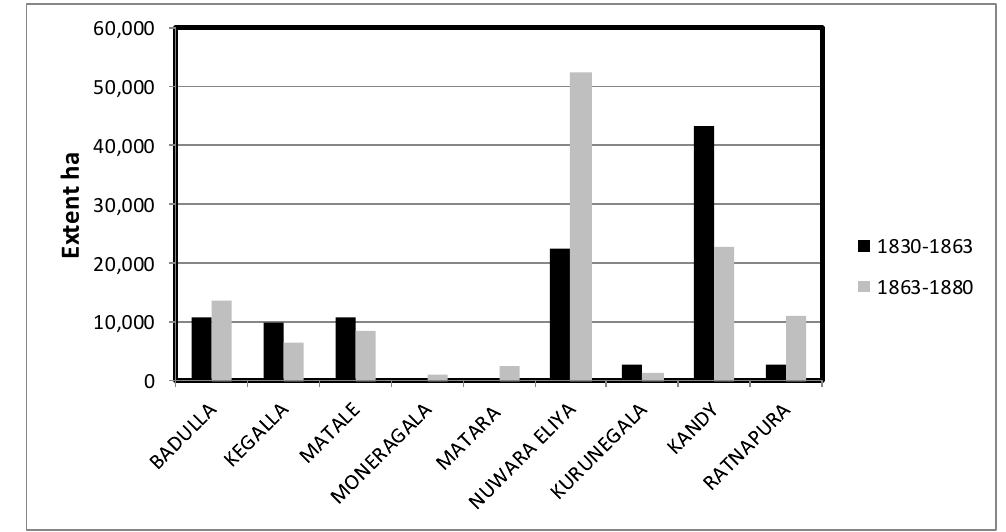
Figure 8: Distribution of coffee estates in the highlands by districts from 1830 to